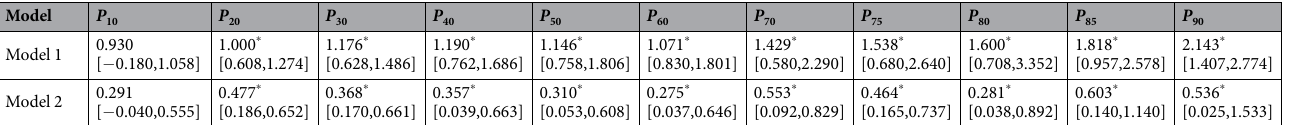
Table 4. Quantile regression coefficients [95% CI ] between FBG and DBP in males. * P < 0.05. CI : confidence interval. Model 1, without adjustments for the confounding factors. Model 2, adjusted for age, BMI, WC, smoking status, alcohol consumption and dyslipidaemia.